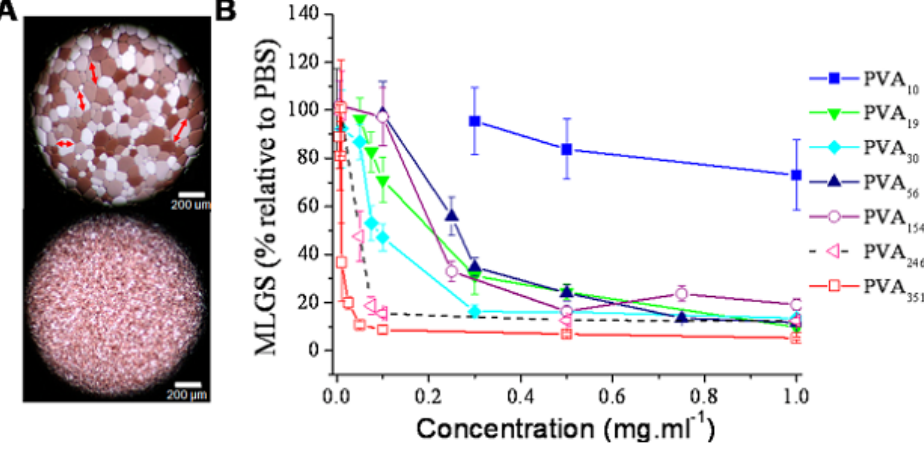
Figure 7. Ice recrystallization inhibition activity of PVA homopolymers as measured by the splat assay. ( A ) Example micrographs showing ice crystals grown in PBS alone (upper) and with PVA351, 1 mg·mL − 1 ); ( B ) Ice recrystallization inhibition activity as a function of polymer concentration. MLGS = mean largest grain size relative to a PBS control, expressed as %. Error bars represent the standard deviation from at least three measurements. Reproduced with permission from et al. Biomacromolecules 2013 , 14 , 1578 [74]. Copyright 2013 American Chemical